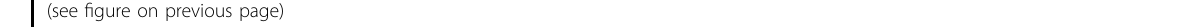
Fig. 4 The H3.3K36M and H3.1K36M mutations inactivate enhancers. A Venn diagram illustrating the overlap of enhancers in wild-type, H3.3K36M-, and H3.1K36M-mutant cells. Enhancers were de fi ned as genomic loci with H3K4me1 peaks, but not overlapped with H3K4me3 peaks or annotated promoters. The enhancers from independent H3.3K36M- and H3.1K36M-mutant clones were pooled. B The normalized H3K27ac read density at enhancers in different cell lines. *** p < 0.001. C The normalized H3K27ac read density at common and unique enhancers in H3.3K36M- and H3.1K36M-mutant cells. A set of shuf fl ed peaks corresponding to unique peaks was used to analyze the enrichment of the ChIP-seq reads. *** p < 0.001. D Percentages of classi fi ed enhancers. Enhancers were classi fi ed according to their enrichment in H3K27ac and H3K27me3. H3K4me1 + /H3K27ac + loci correspond to active enhancers; H3K4me1 + /H3K27me3 + loci correspond to primed enhancers, and H3K4me1 + /H3K27ac − loci correspond to poised enhancers. E The H3K27me3, H3K27ac, H3K4me1, and H3K4me3 enrichments at the classi fi ed enhancers were analyzed via ChIP-qPCR. The data are represented by the mean ± SD ( N = 3 independent replicates). Po1, Po2, and Po3, poised enhancers in all cell lines. Pr1, Pr2, and Pr3, primed enhancers in all cell lines. Ac1, Ac2, and Ac3, active enhancers in all cell lines. uPo1, Upo2, and uPo3, unique poised enhancers in mutant cells, uPr1, uPr2, and uPr3, unique primed enhancers in mutant cells. uAc1, uAc2, and uAc3, unique active enhancers in wild-type cells. NE, intergenic locus without H3K27me3, H3K27ac, H3K4me1, and H3K4me3 was used as negative controls. ACT, genomic locus of ACTB which was actively expressed was used as the positive control for H3K27ac and H3K4me3. F H3K27ac decreased in the intergenic regions with decreased H3K36me2. The H3K27ac enrichment at H3K36me2-decreased intergenic regions was analyzed in H3.3K36M- and H3.1K36M-mutant cells. *** p < 0.001. G Correlations between the changes of H3K27ac and H3K36me2 in wild-type and mutant cells. The active enhancers in wild-type cells that were within the H3K36me2 peaks were chosen for the analysis. The correlations were assessed by Pearson product moment correlation. H Box plots showing the expression levels of genes associated with distinct classes of enhancers. FPKM transcript per million mapped reads. ** p < 0.01, *** p < 0.001. I The percentage of upregulated and downregulated genes that were associated with inactivated enhancers. Genes that were signi fi cantly changed in H3.3K36M- and H3.1K36M-mutant cells were used for this analysis. J , K The expression changes of genes associated with different number of inactivated enhancers in H3.3K36M- ( J ) and H3.1K36M- ( K ) mutant